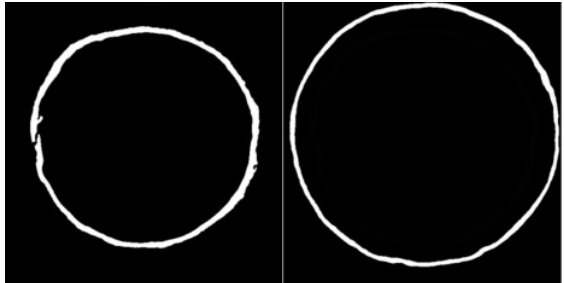
Figure 8. After realizing the connectivity domain.